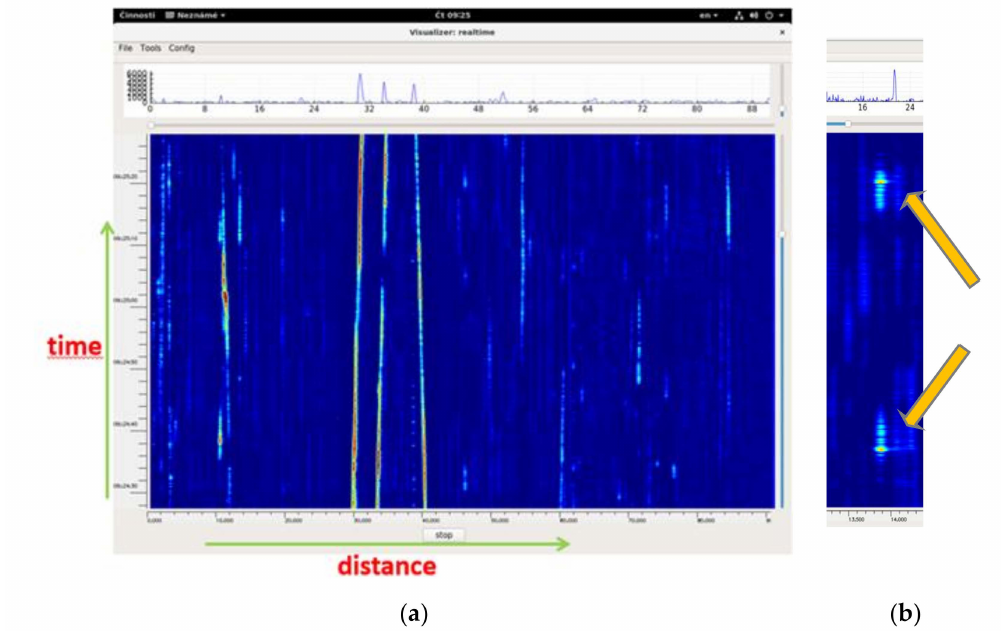
Figure 20. Waterfall with the occurrence of ( a ) multiple simultaneous events—“waterfall”, ( b ) two events when a vehicle is passing a rail